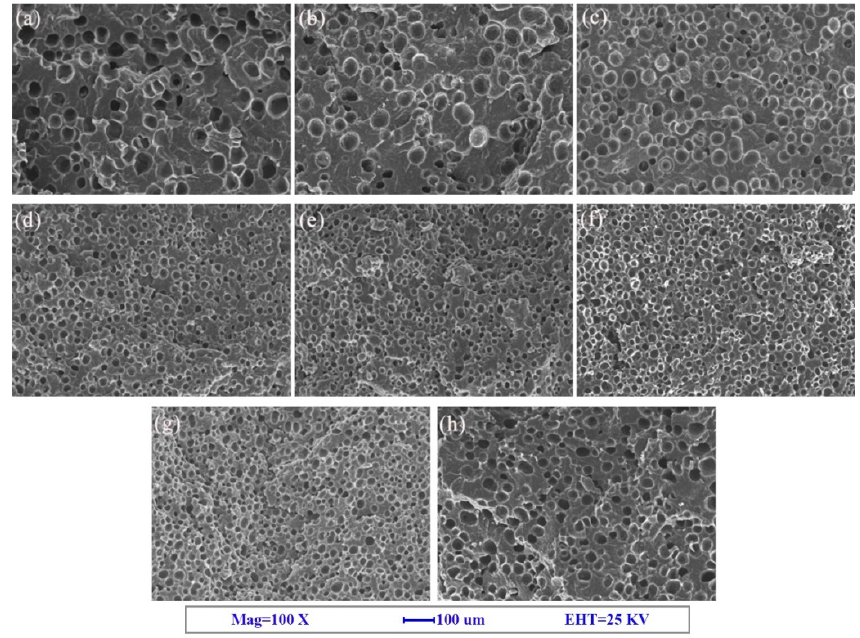
Figure 2. SEM images of the polypropylene (PP) and PP + cucurbit[6]uril (Q[6]) (PQ) composite foams: ( a ) PP, ( b ) PQ0.25, ( c ) PQ0.5, ( d ) PQ1, ( e ) PQ2, ( f ) PQ3, ( g ) PQ5, and ( h ) PQ7.